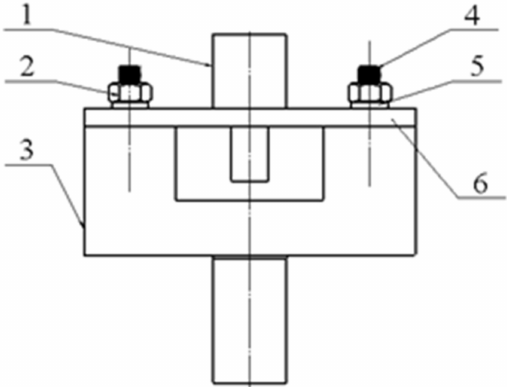
Figure 9. The structure of the fixture model in the pull-out test. 1. NiTiNb SMA parts; 2. nuts; 3. fixture base; 4. double-headed studs; 5. gaskets; 6. aluminum alloy structural